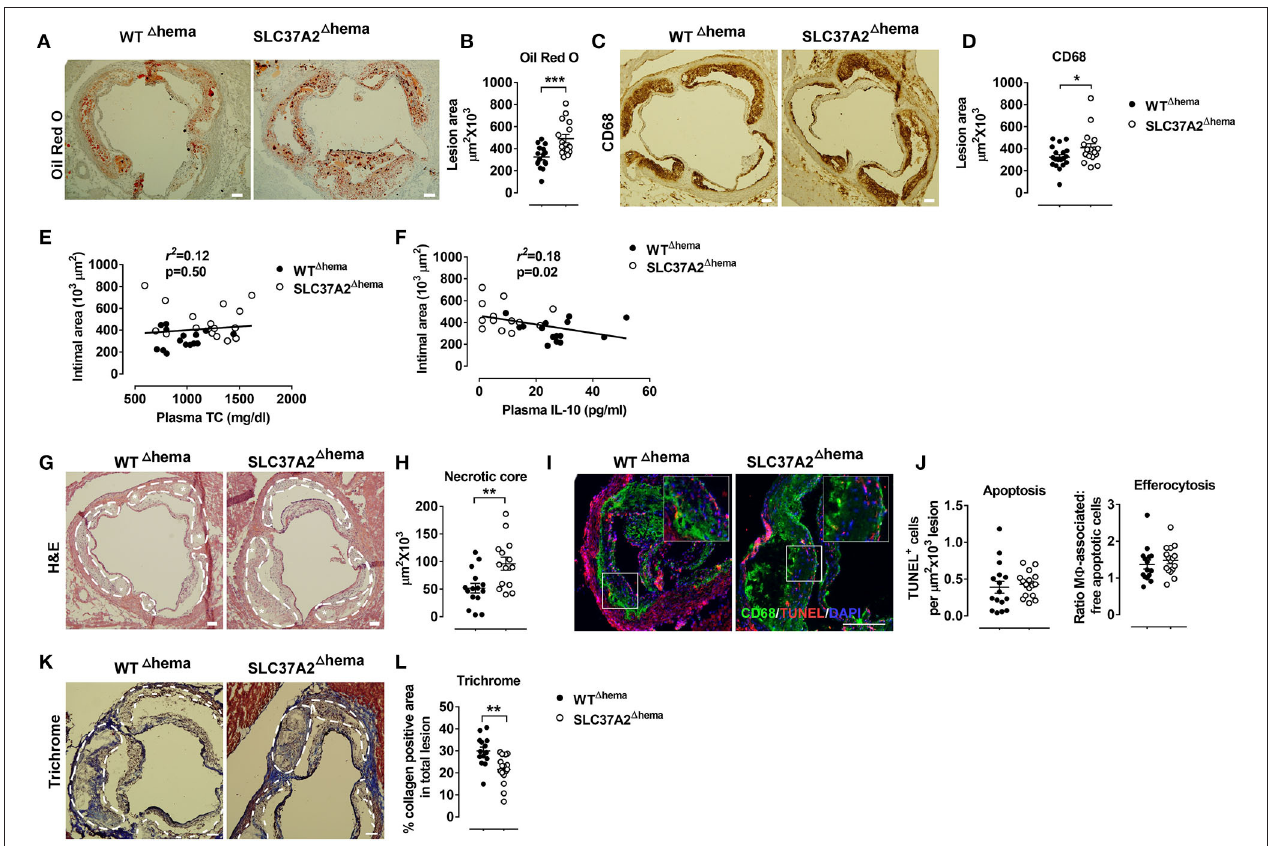
FIGURE 4 | Hematopoietic cell-specific SLC37A2 deficiency promotes atherosclerosis in WD-fed Ldlr − / − mice. Hematopoietic SLC37A2 knockout (SLC37A2 1 hema ) and control (WT 1 hema ) Ldlr − / − mice were fed a high-fat western diet for 16 wks ( n = 12-16 mice per genotype). (A,B) Quantification of Oil Red O positive intimal area in the aortic root. (C,D) Quantification of CD68 + cells (macrophages) in the aortic root intimal area. (E) Linear regression analysis of aortic root intimal area vs. plasma total cholesterol of 16-wk diet-fed mice. Each point represents an individual animal of the denoted diet group and the correlation coefficient is shown for the entire data set. (F) Linear regression analysis of aortic root intimal area vs. plasma IL-10 of 16-wk diet-fed mice. Each point represents an individual animal of the denoted diet group and the correlation coefficient is shown for the entire data set. (G,H) Quantification of the aortic necrotic intimal area (total necrotic area) in H&E stained aortic root sections. White dash line circled lesion areas. White stars indicate the necrotic area in the plaques. (I,J) Quantification of apoptosis (TUNEL-positive cells) and efferocytosis (the ratio of macrophage-associated: free apoptotic cells) in aortic root sections. CD68 (green; macrophages), TUNEL (red), and DAPI (blue; nuclei) were labeled fluorescently. (K,L) Quantification of aortic Trichrome stain positive cells. White dash line circled lesion areas. Scale bars = 100 µ m. Each symbol represents an individual mouse. Data are expressed as mean ± SEM. n = 12-16 mice per group. * p < 0.05; ** p < 0.01; *** p <